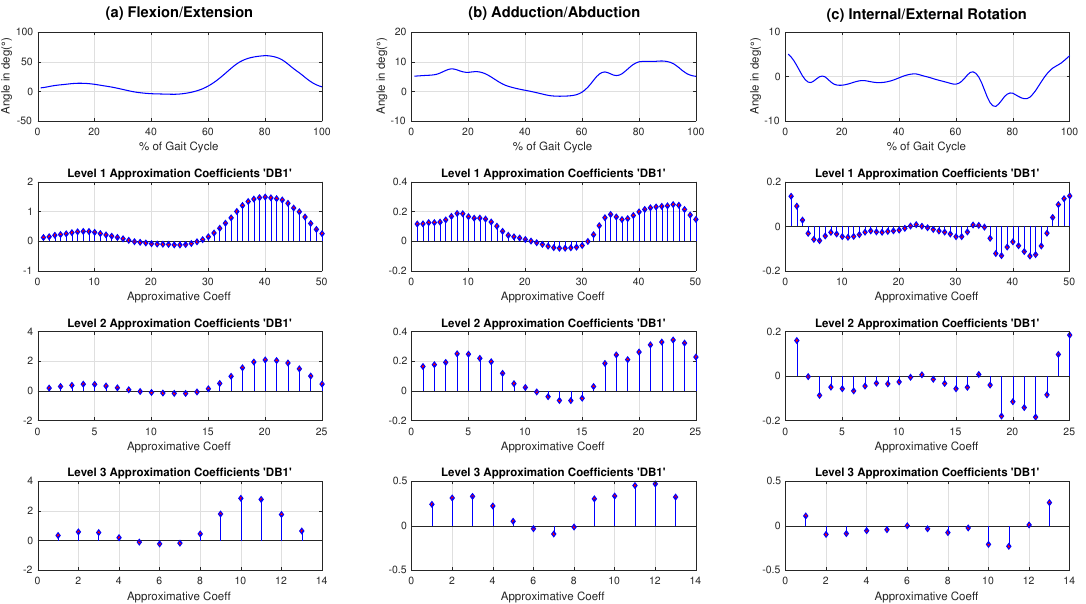
Figure 4. Wavelet decomposition using Daubechies db1 of the (a) the flexion/extension angle, with respect to the sagittal plane, (b) the abduction/adduction angle, with respect to the frontal plane, (c) and internal/external angle, with respect to the transverse plane. Each line corresponds to a decomposition level and each column to a kinematic plane.